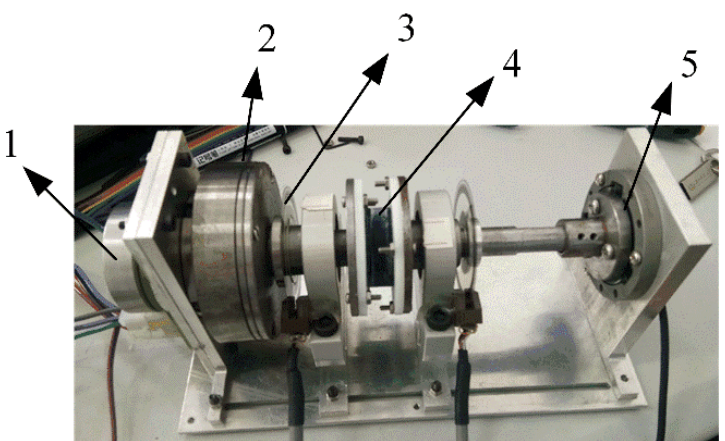
Figure 9. Rubber testing device: (1) motor, (2) harmonic drive, (3) photoelectric encoder, (4) rubber, (5) torque sensor. The left end of the rubber is connected to a motor, and the right end is fixed and connected to a torque sensor. Two encoders respectively record the angle changes at the left and right ends of the rubber. The difference between the two is used as the deformation of the rubber.